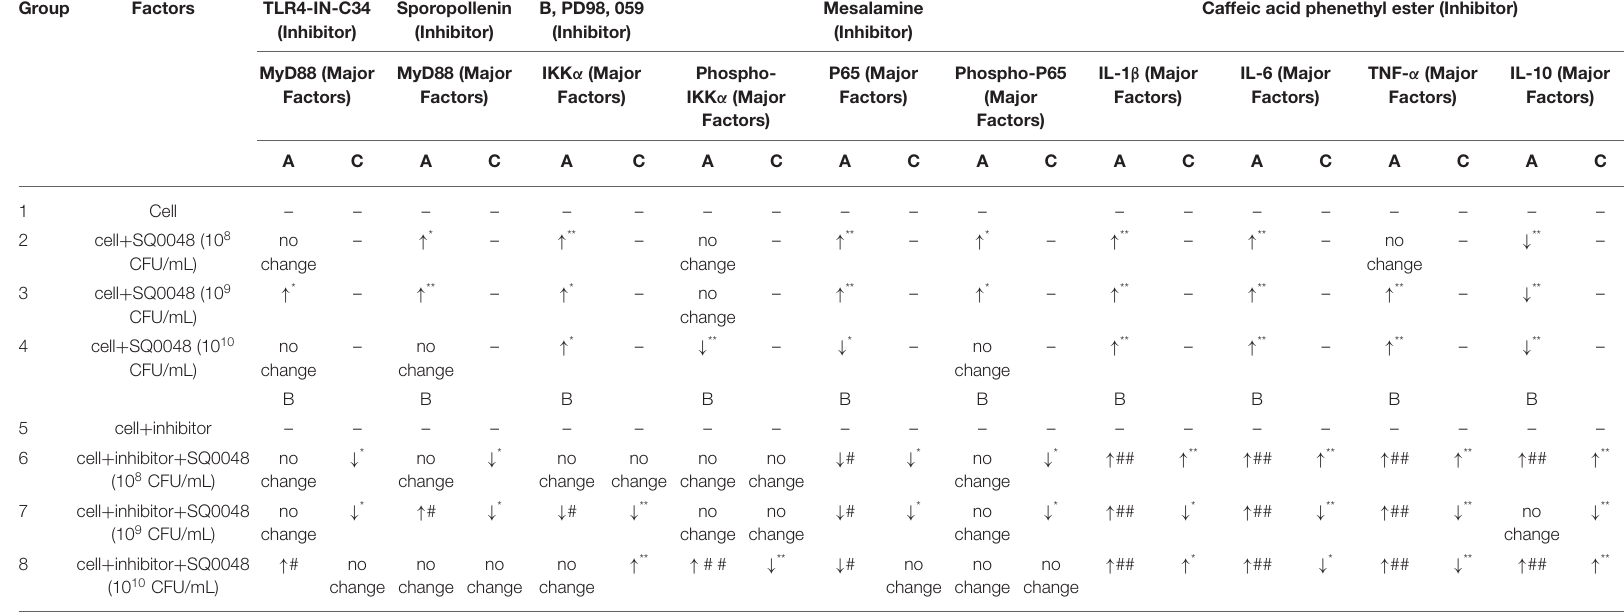
TABLE 2 | Inflammatory mediator protein expression.